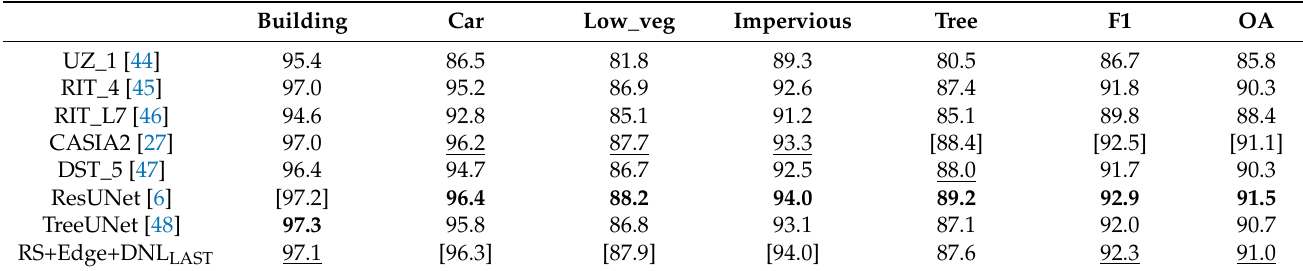
Table 6. Accuracy comparison (%) with state-of-the-art deep convolution neural network (DCNN) models on the Potsdam benchmark using an edge-eroded reference. The best results are marked in bold, the second-best results are enclosed in square brackets, and the third-best results are underlined.